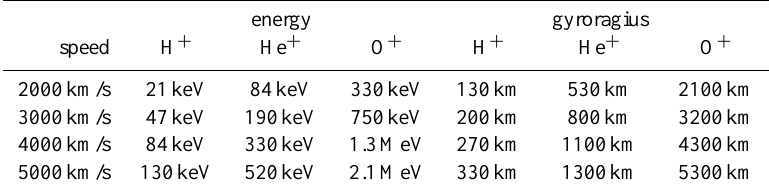
Table 2. Gyroradius of major ring current ions under 160nT magnetic field.